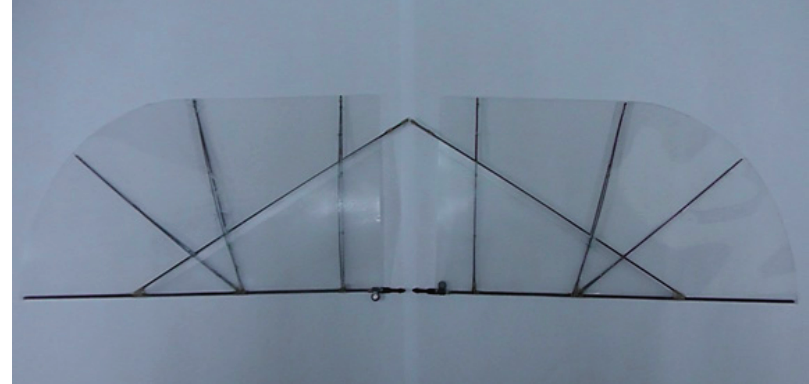
Figure 19. Skeletal structure for polyethylene terephthalate (PET) cambered thin wing (CAD Model).